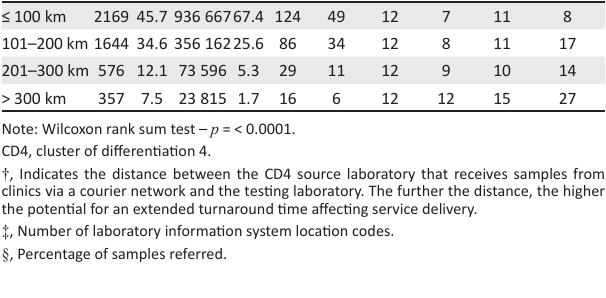
TABLE 2: Laboratotry-to-laboratory performance of inter-laboratory referral routes over 300 km and involving at least 1000 referred samples in the 2018 calendar year for National Health Laboratory Service laboratories in South